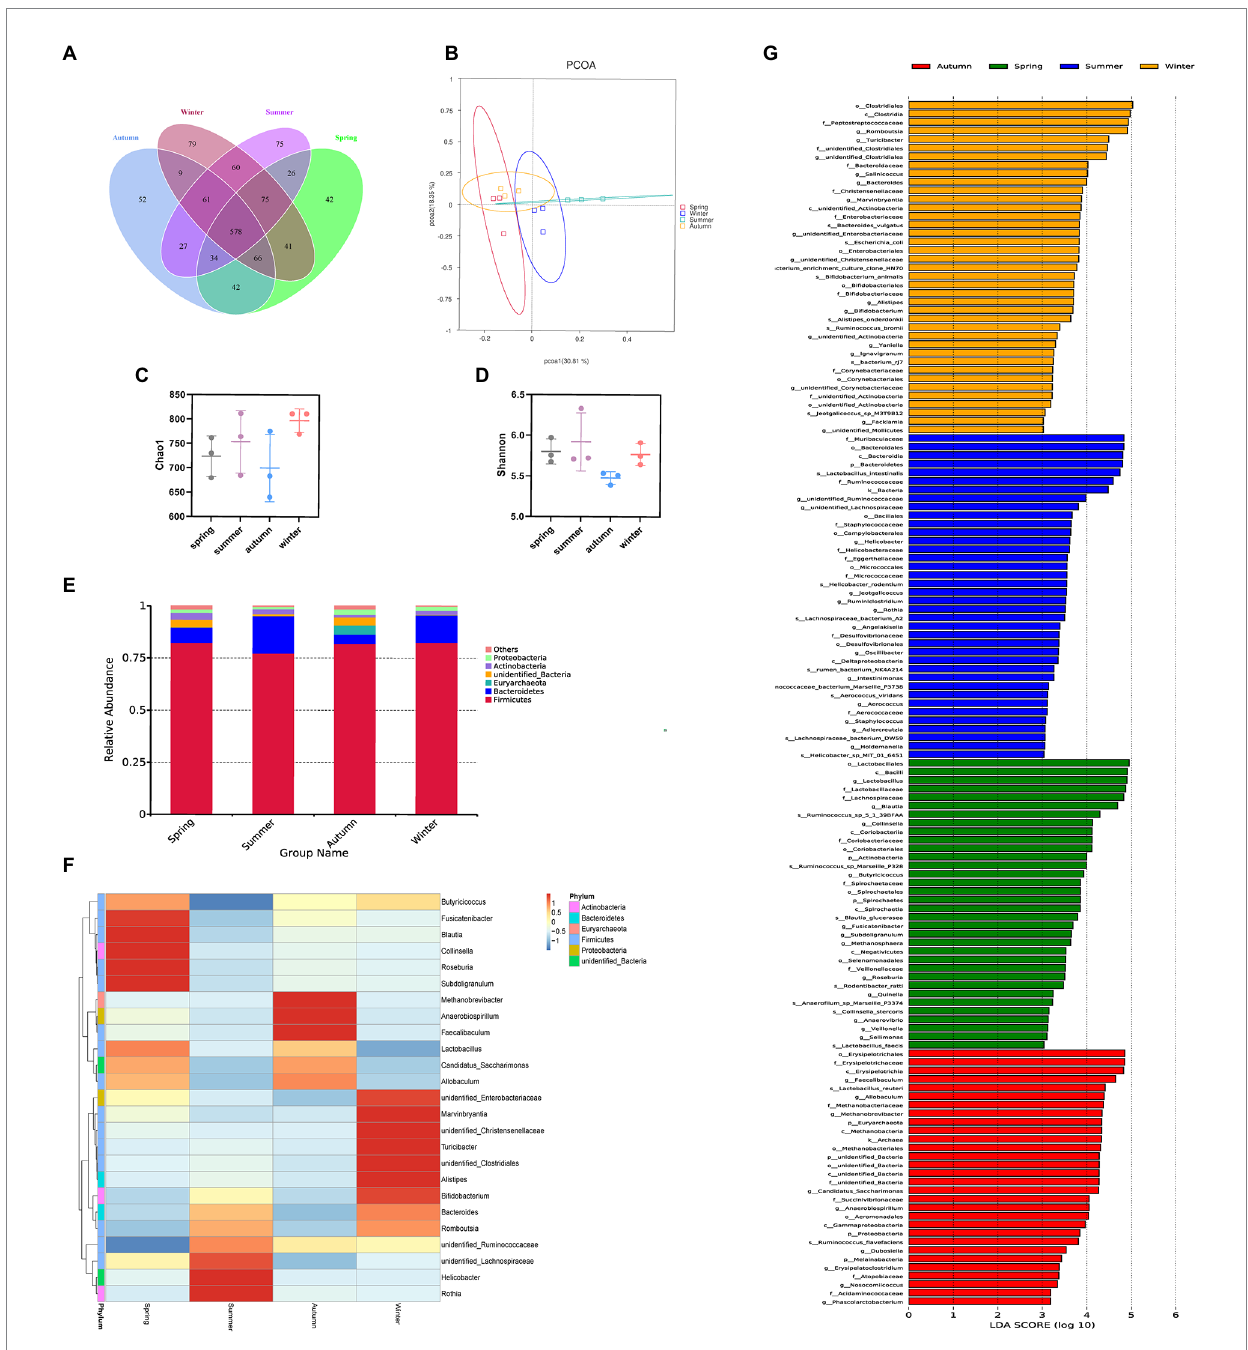
FIGURE 6 Different seasons affect the structure and composition of the intestinal flora. (A) The Venn diagram of spring, summer, autumn, and winter groups. (B) PCoA score. (C) Chao index. (D) Shannon index. (E) Columnar accumulation plot of relative species abundance at the phylum level: top 6 species according to the abundance were selected for each group. (F) Heatmap of gut microbiota at the genus level: top 25 genera according to the abundance were selected for each group (the abundance of each group was the average of all samples in the group). (G) The LEfSe